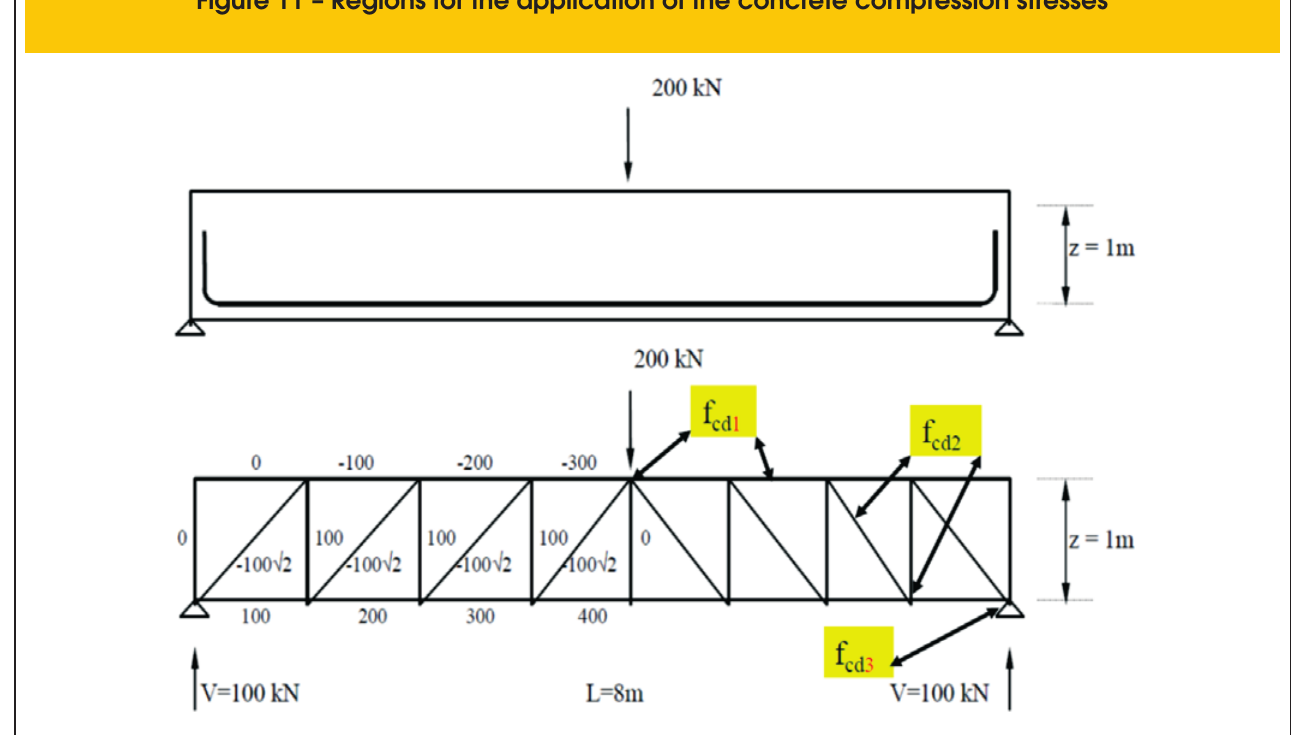
Figure 11 – Regions for the application of the concrete compression stresses